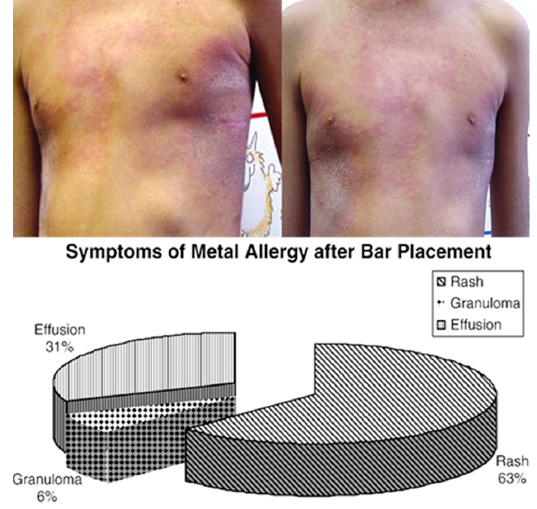
Figure 2. Top image: Photographs of a patient with erythema and rash after implantation of a stainless steel bar. Bottom image: typical symptoms reported in patients implanted with steel bars as part of a Nuss procedure for repair of pectus excavatum. Patients did not have a history of metal allergy prior to implantation. Reproduced with permission from